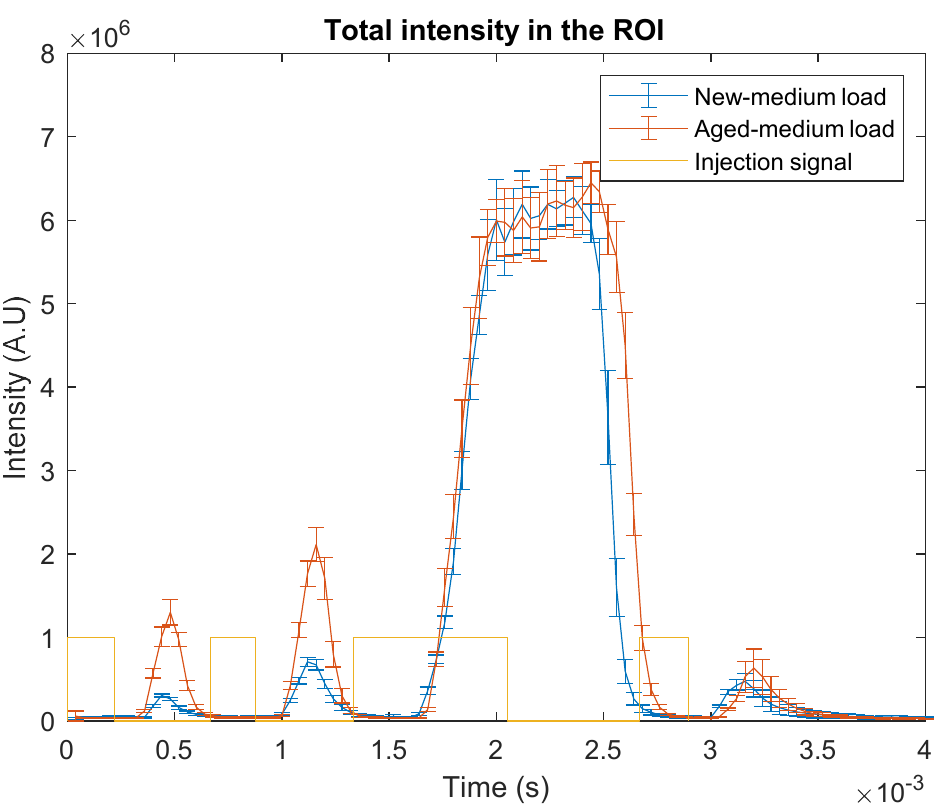
Figure 6. Mie-scattering signal at medium load using different injectors.